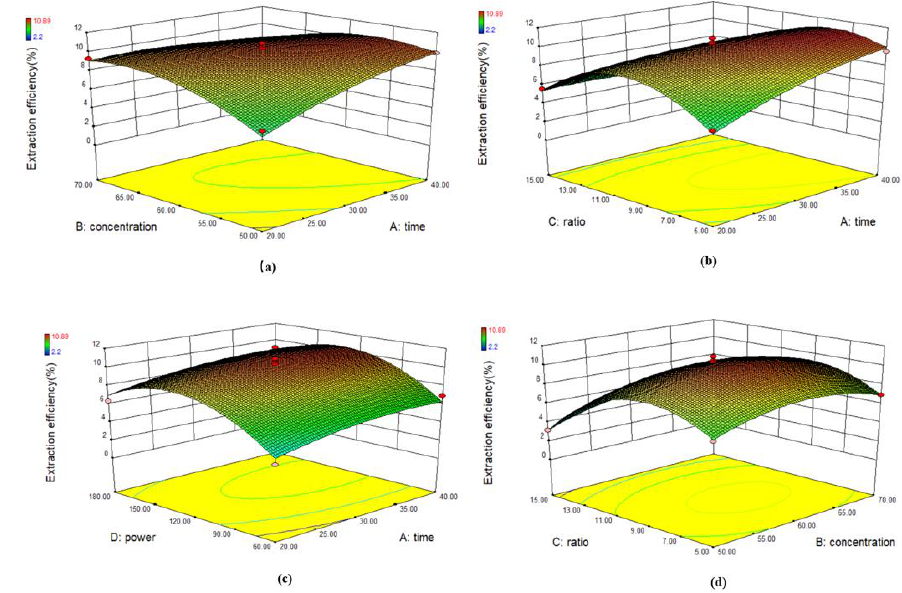
Figure 7. The predicted values versus the actual values. The RSM curve reflects the influence of each variable on the extraction efficiency of flavonoids, and the visualization of the prediction model equation can be obtained by surface response graph. The three-dimensional response surface diagram and two-dimen- sional contour map of the factors affecting the extraction efficiency of flavonoids are shown in Figure 8. If the slope of the response surface graph is relatively flat, it indicates that the response value has little effect with the change of extraction conditions; on the contrary, if the slope of the response surface is steep, it indicates that the response value has a great influence with the change of extraction conditions. The maximum response value appears in the center of the ellipse and decreases gradually from the center to the edge. The shape of contour map can reflect the degree of interaction; an ellipse shows significant interaction between factors, while a circle shows no significant interaction. There is a significant interaction between the material liquid ratio and the extraction power, while the interaction between other factors is not significant.